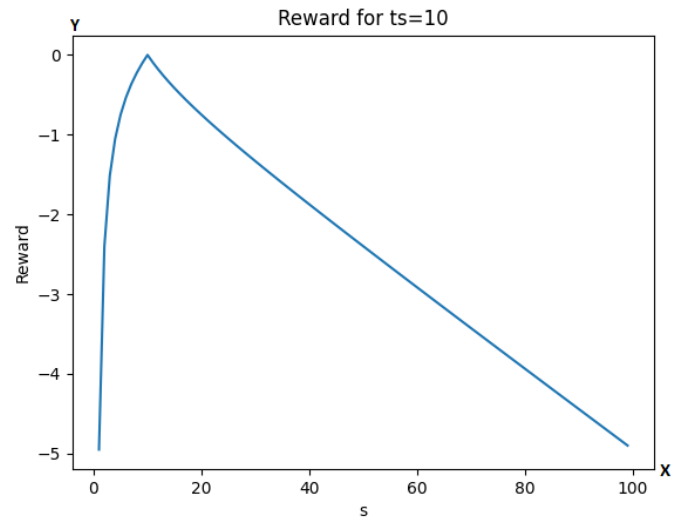
Figure 2. Graph of the reward function for different values of s at ts = 10m. The y -axis is representing the reward value, while the x -axis is representing the number of simulation